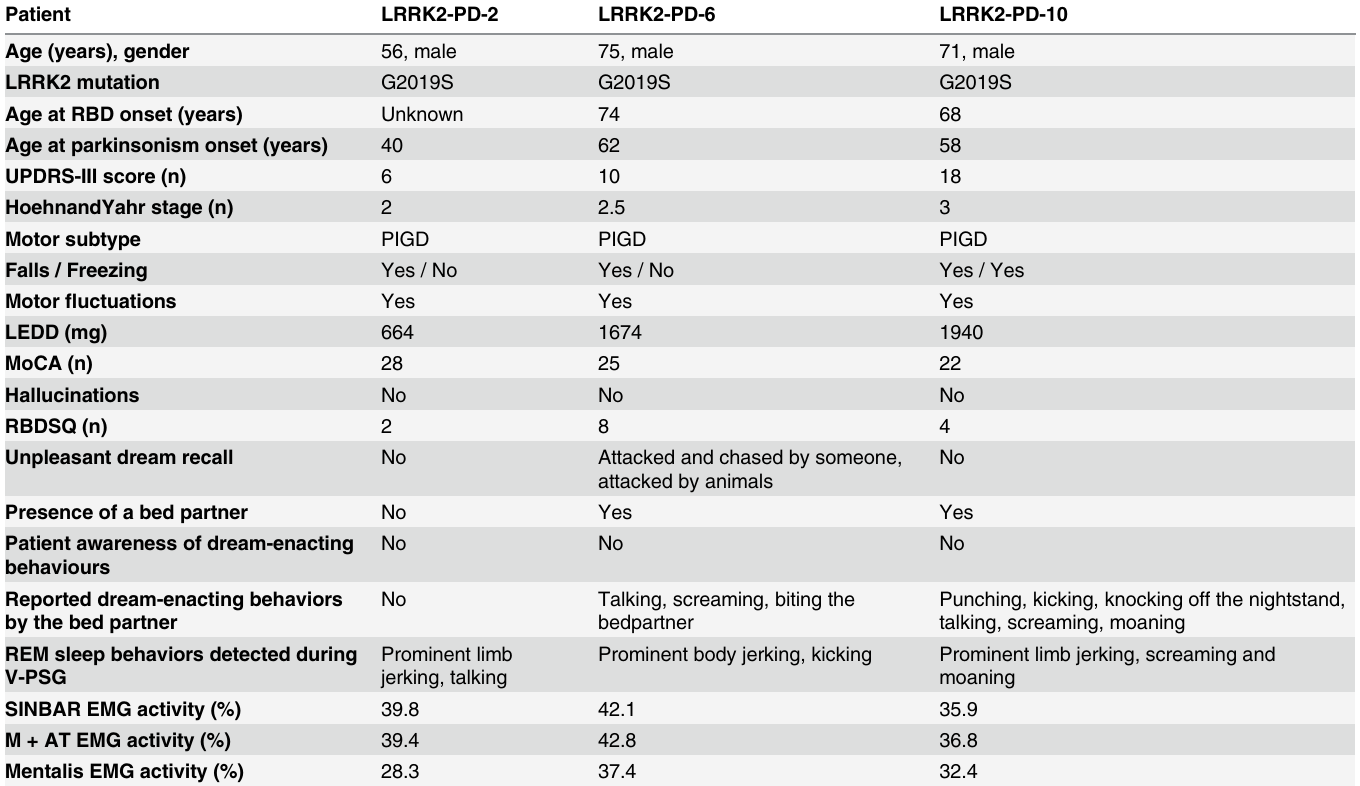
Table 5. LRRK2-Parkinson Disease patients with associated REM sleep behavior